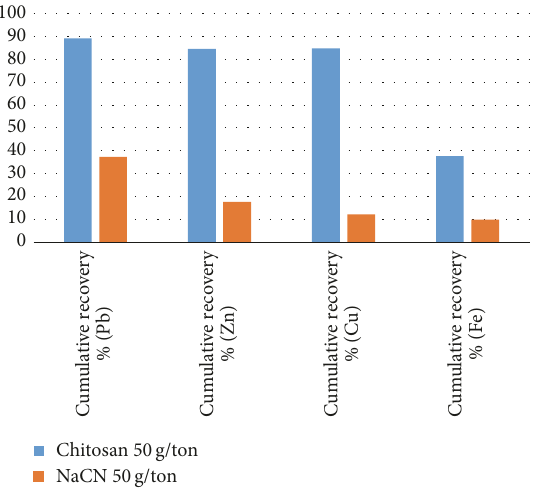
Figure 11: Comparison of flotation recoveries of different sulfide minerals in the concentrate products when using either chitosan or NaCN at equivalent dosage of of 50